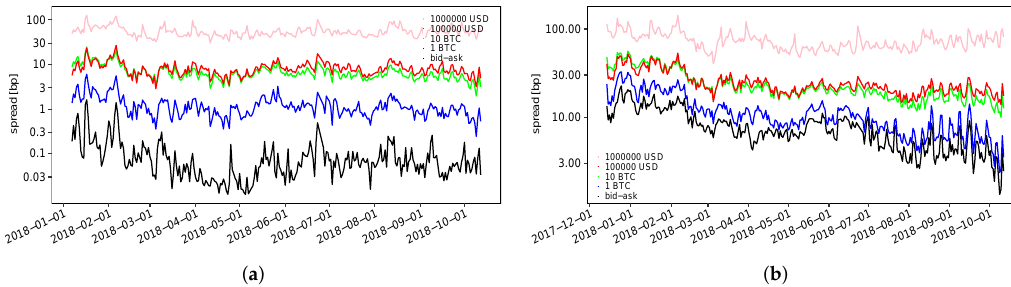
Figure A2. Evolution of daily average liquidity costs. The figure displays the daily averages of the bid-ask spread ˜ s ( t ) and the volume-weighted average price spread ˜ vs ( ω , t ) for different volumes ω . ( a ) Coinbase BTC/USD market; ( b ) Bitstamp BTC/USD market.